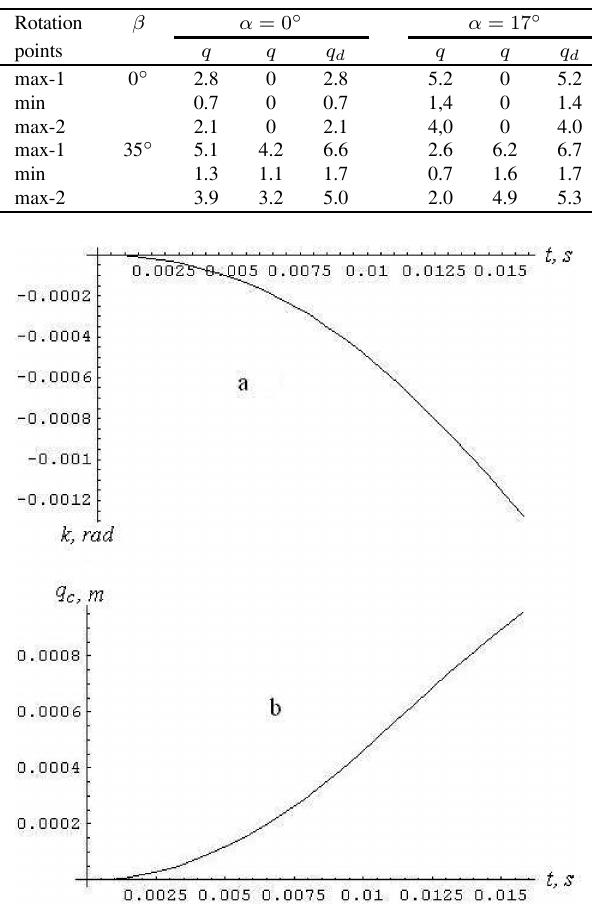
Fig. 6. (a) Angle of rotation of a stabilizer with a riser; (b) bending displacement of the free ends of the central rod. 4.6 s after string release (Fig. 7). The fi rst minimum appears at 9.4 ms and the second maximum at 12.7 ms.